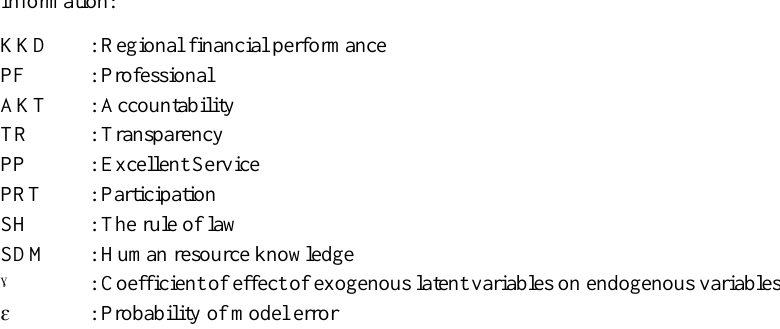
Test Parameter Rule of Thumbs Convergent Average Variance Extracted (AVE) Discriminant Ave Root and Latent Variable Correlation Reliability Cronbach’s Alpha Source: Abdillah & Hartono (2015:196-197) Hypothesis